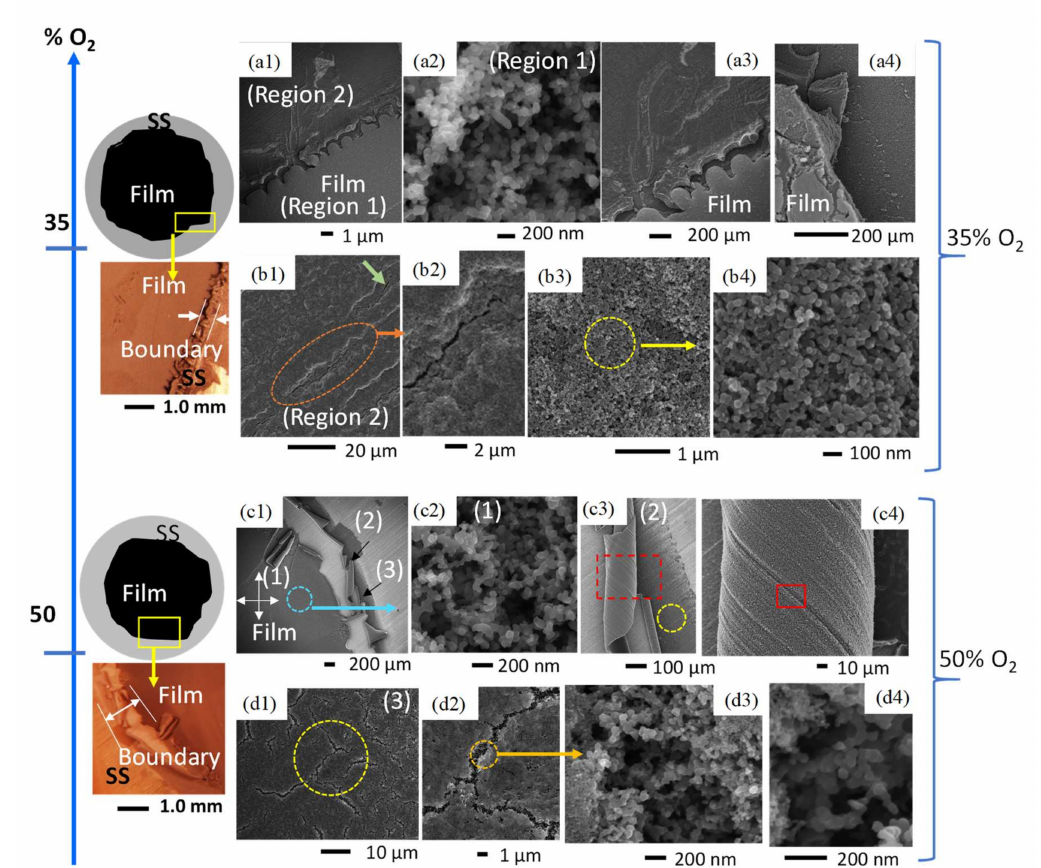
Figure 5. Comparative diagrams, light microscopy images, and SEM images of C-layers formed in CME/35% O 2 and CME/50% O 2 flames. At 35% O 2 , a light and dark contrast was observed ( a1 – a4 ), with the lighter-contrast area producing weblike structures ( a2 ) and the area of darker contrast consisting of compacted soot with microscale cracks ( b1 – b4 ). CME flames with 50% O 2 produced three regions of deposits ( c1 ). the first formed by typical weblike structures ( c2 ); the second made up of early soot deposits that have been curled ( c3 , c4 ); and the third comprising compacted soot that has been significantly fractured ( d1 – d4